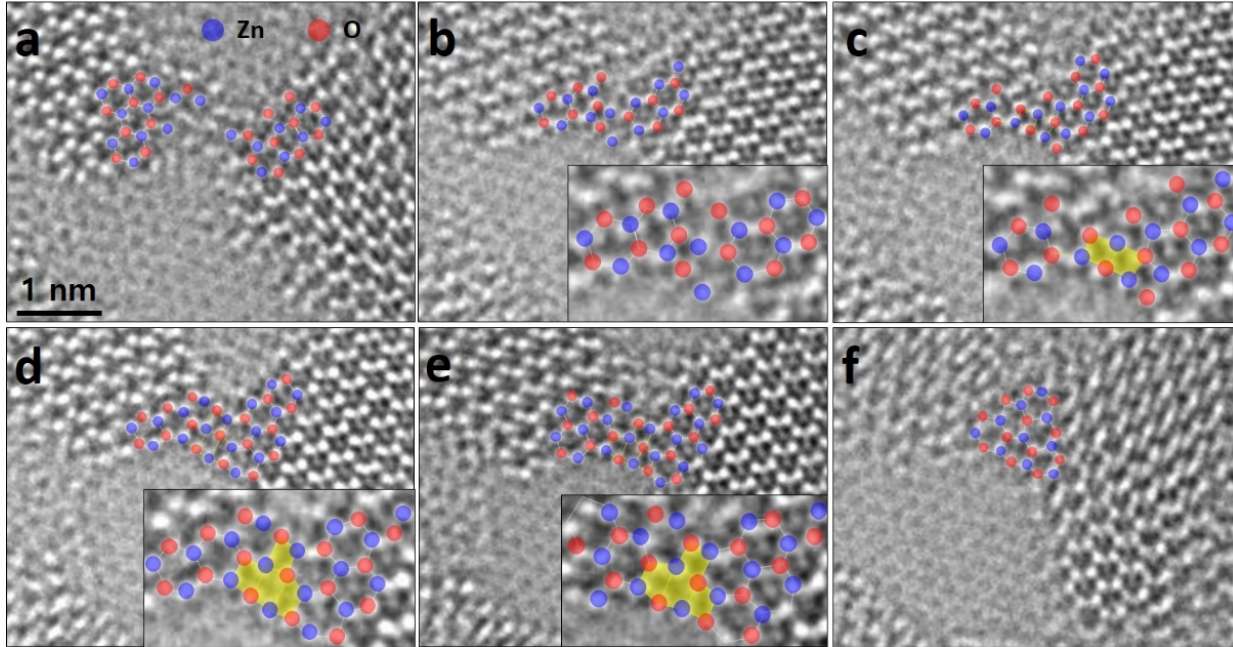
Figure 5. Atomic arrangement of bridged-atoms of the merging. ( a ) Initial state before the merging of the flakes. ( b – e ) Intermediate states showing the rectangular lattices with insets of the magnified bridged regions. ( f ) Final state after the merging. Raw images are supported as Figure S4.